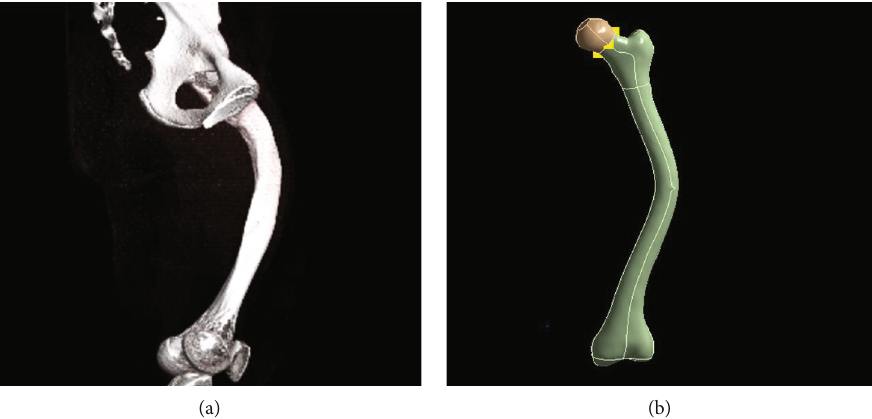
Figure 1: Reconstruction of geometrical model of OI bone: (a) CT image of OI patient; (b) reconstructed fi nite element model of OI-a ff ected